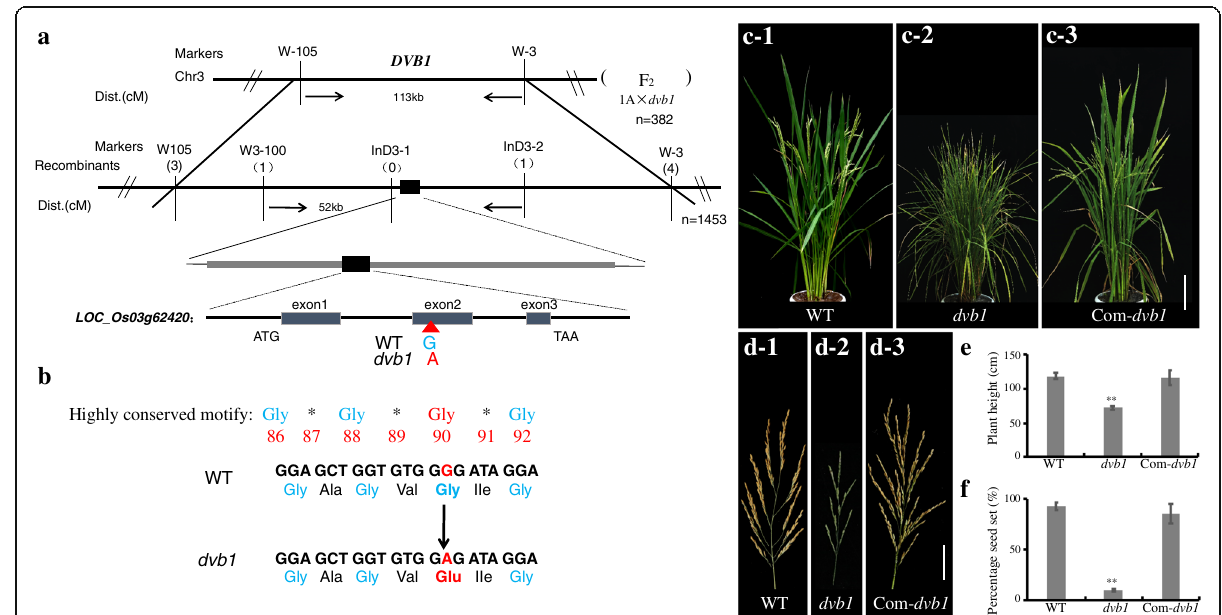
Fig. 3 Molecular cloning of DVB1 . a Fine-mapping of DVB1 on chromosome 3. The thick black line represents the chromosome, the markers used for gene mapping are indicated above the black line, numbers in brackets represent recombinants, the value below the line represents the genetic distance (cM) between two markers, and n is the total number of F 2 genotyped plants. b The dvb1 mutant harbors a nucleotide G-to-A transition in exon 2, leading to a Gly- to-Glu amino acid conversion at site 90 in the core region. c Plant of the wild type (c-1), dvb1 mutant (c-2), dvb1- complementary transgenic plants (c-3). Scale bars: 15cm. d Panicle morphology of wild type (D-1), dvb1 mutant (D-2), dvb1- complementary transgenic plants (D-3), Scale bars: 50mm. e – f Plant height ( e ) and percentage seed set ( f ) of wild type, dvb1 mutant, dvb1- complementary transgenic